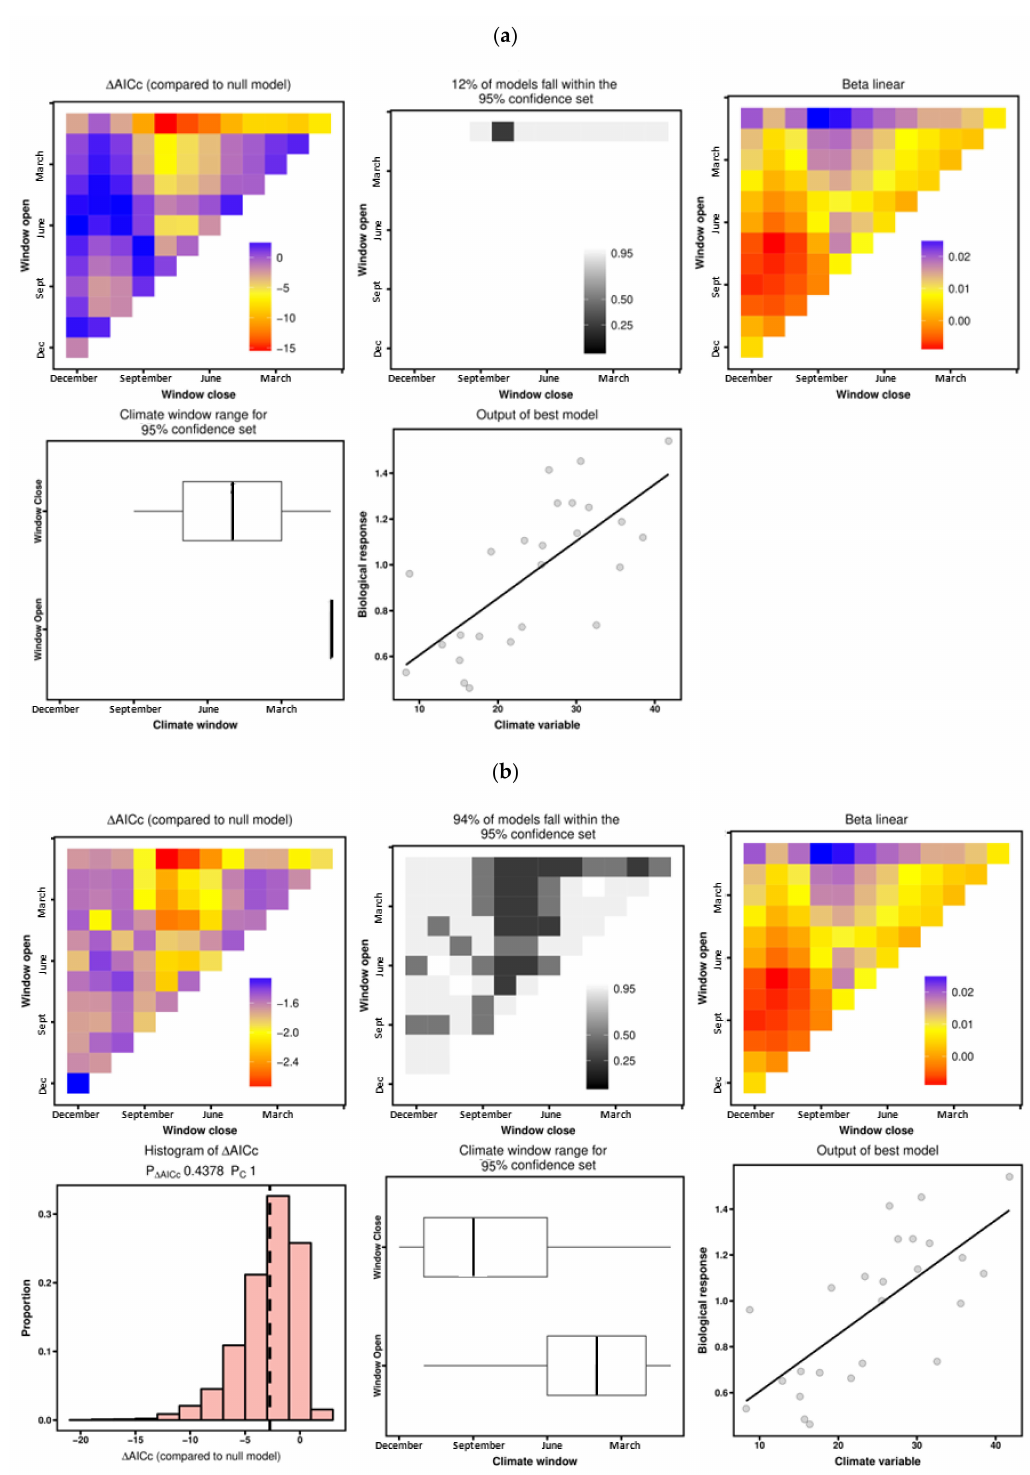
Figure 5. Examples of “ climwin” output panels by calculating ( a ) linear models without and ( b ) with K-fold cross-validation and randomization method. The example corresponds to precipitation and the Pistacia lentiscus chronology. The model was not significant ( p < 0.05) according to randomization tests (histogram of ∆ AICc values; the vertical dashed line shows the ∆ AICc of the best model fitted on the observed